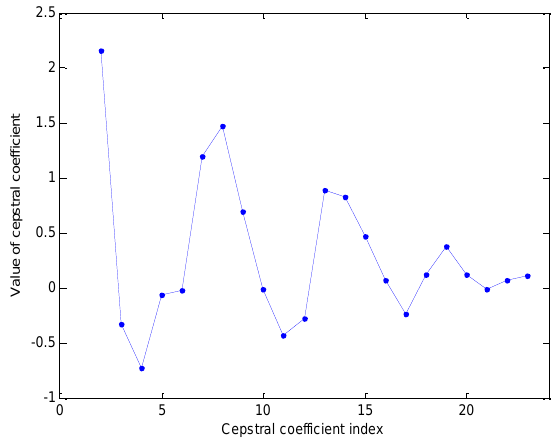
Figure 13. The DCT cepstral representation of an anuran sound frame.